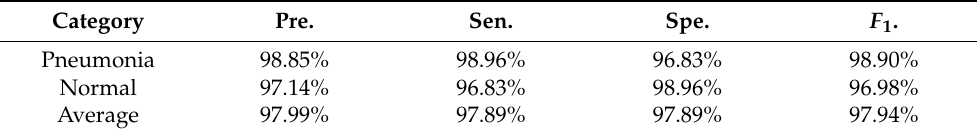
Table 8. Recognition results of the BoT-ViTNet model on the Coronahack dataset.